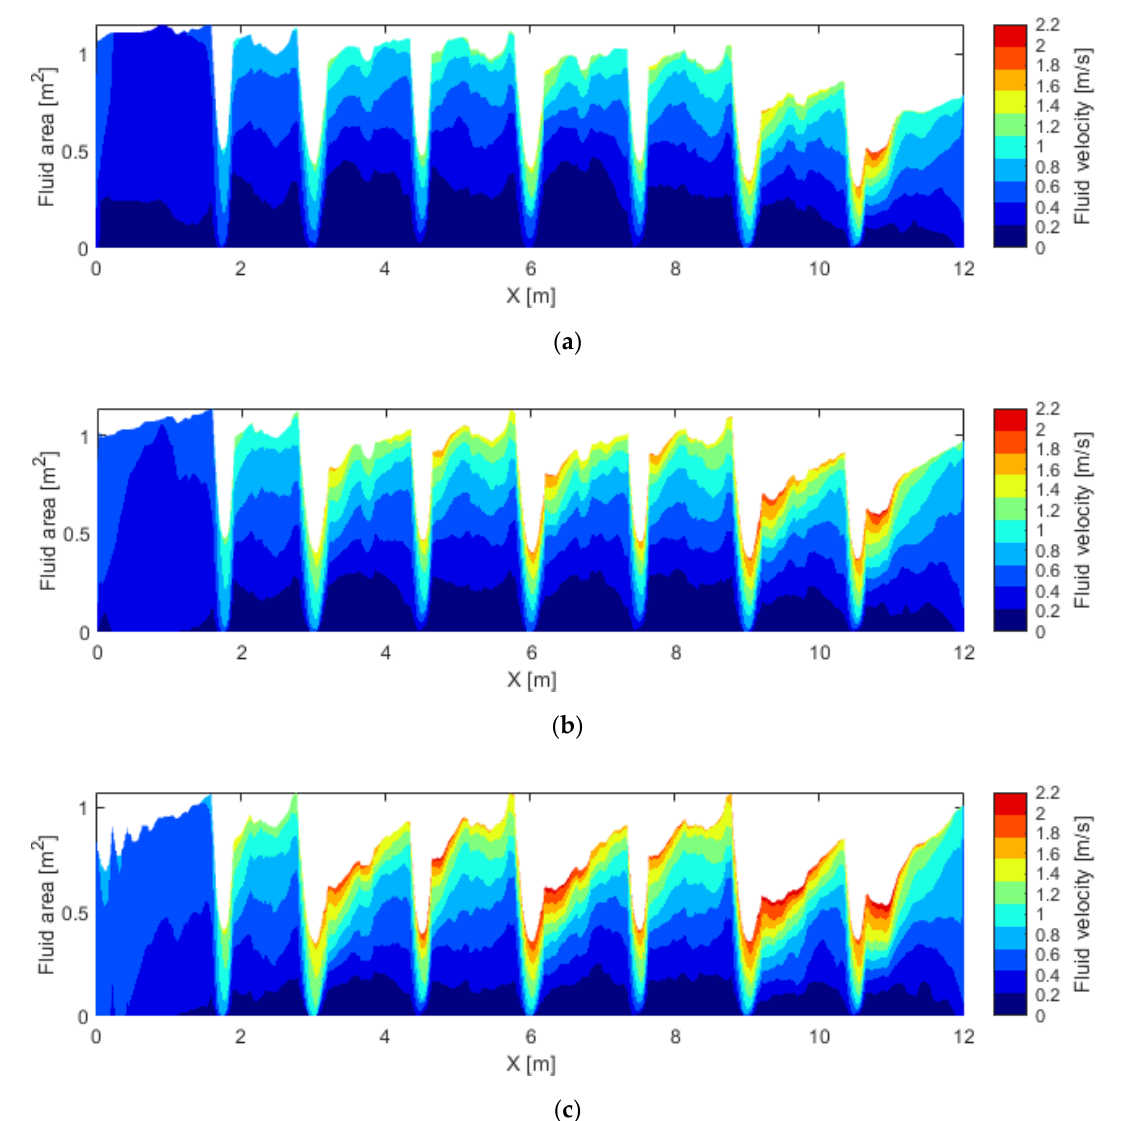
Figure 15. Area-velocity ratio for the Q 2 case ( a ) for I = 1.5 %, ( b ) I = 3 %, ( c ) I = 5